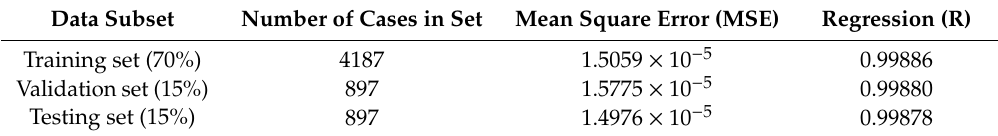
Table 1. Training results for the multilayer perceptron (MLP) artificial neural network (ANN) by data subset.